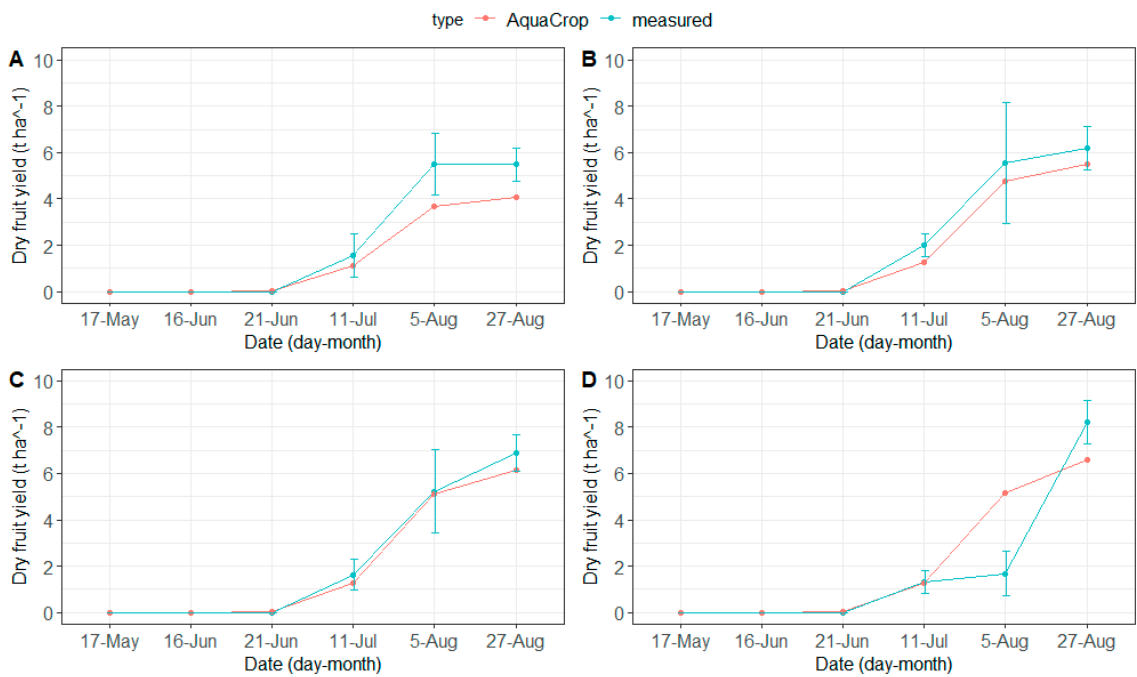
Figure 4. Simulated and measured yield values for the 2019 growing season (validation). Error bars represent the standard deviation (n = 4). The ( A – D ) letters refer to the K, I50, I75, and I100 treatments, respectively.